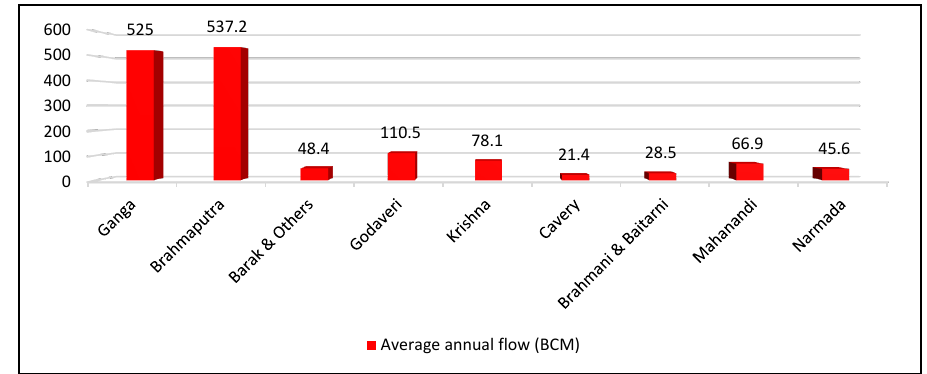
Figure 2. River basin flows in India (2015). Source: Water and Related Statistics (2015), Central Water Commission BCM: Billion Cubic Meter.